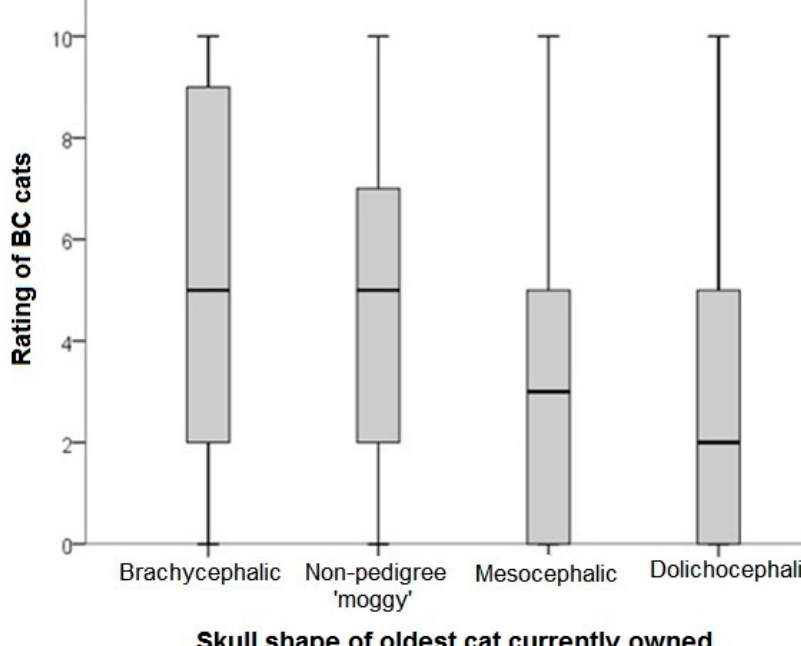
Figure 4. Ratings of liking (0 = I don’t like this cat at all; 10 = This is my favorite kind of cat) for cats identified as having mild to extreme brachycephaly (BC; n = 7/15 cat images as per Table 1). Ratings were provided by n = 1239 respondents. Comparisons are relative to skull morphology of the eldest cat currently owned, as based on reported breed and associated pedigree breed